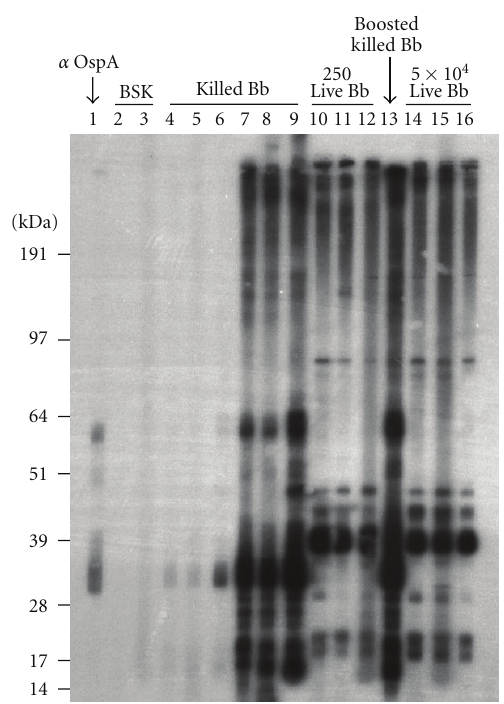
Figure 2: Antibodies produced against live and killed spirochetes recognize unique Bb antigens. Sera were collected from individual mice 4 weeks after injection with a single dose of either BSK II medium (lanes 2-3), 5 × 10 7 killed Bb (lanes 4–9), 250 live Bb (lanes 10–12), or 5 × 10 4 live Bb (lanes 14–16); one group initially received 10 5 killed Bb + CFA, with a boost 3 weeks later with 10 5 killed Bb + IFA, and sera collected 3 weeks later (lane 13). All sera were diluted either 1:25 (lanes 2-3 and 7–9) or 1 :500 before using to immunoblot membranes containing electrophoresed Bb. A mAb specific for Bb OspA, H5332 [49], was included as a marker for OspA reactivity (lane